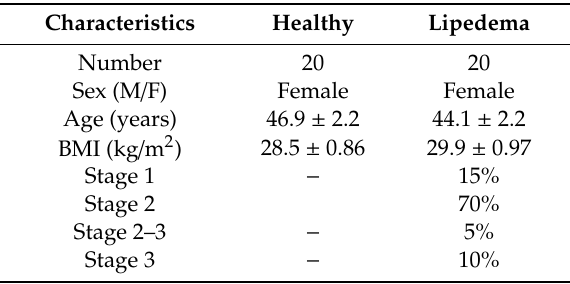
Table 1. Characteristics of healthy and lipedema